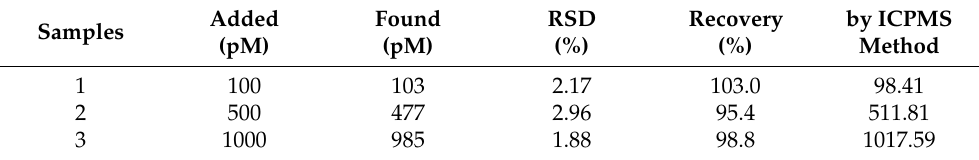
Table 2. Recovery results of CAP in honey samples ( n =